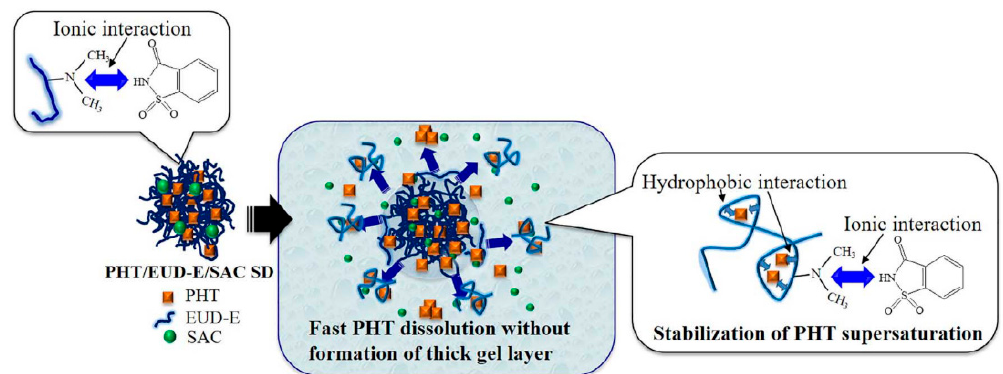
Figure 7. Schematic interpretation of phenytoin dissolution and supersaturated solution formed by phenytoin: Eudragit EPO: saccharin ASDs. (Adapted with permission from [126], Elsevier, Inc.,